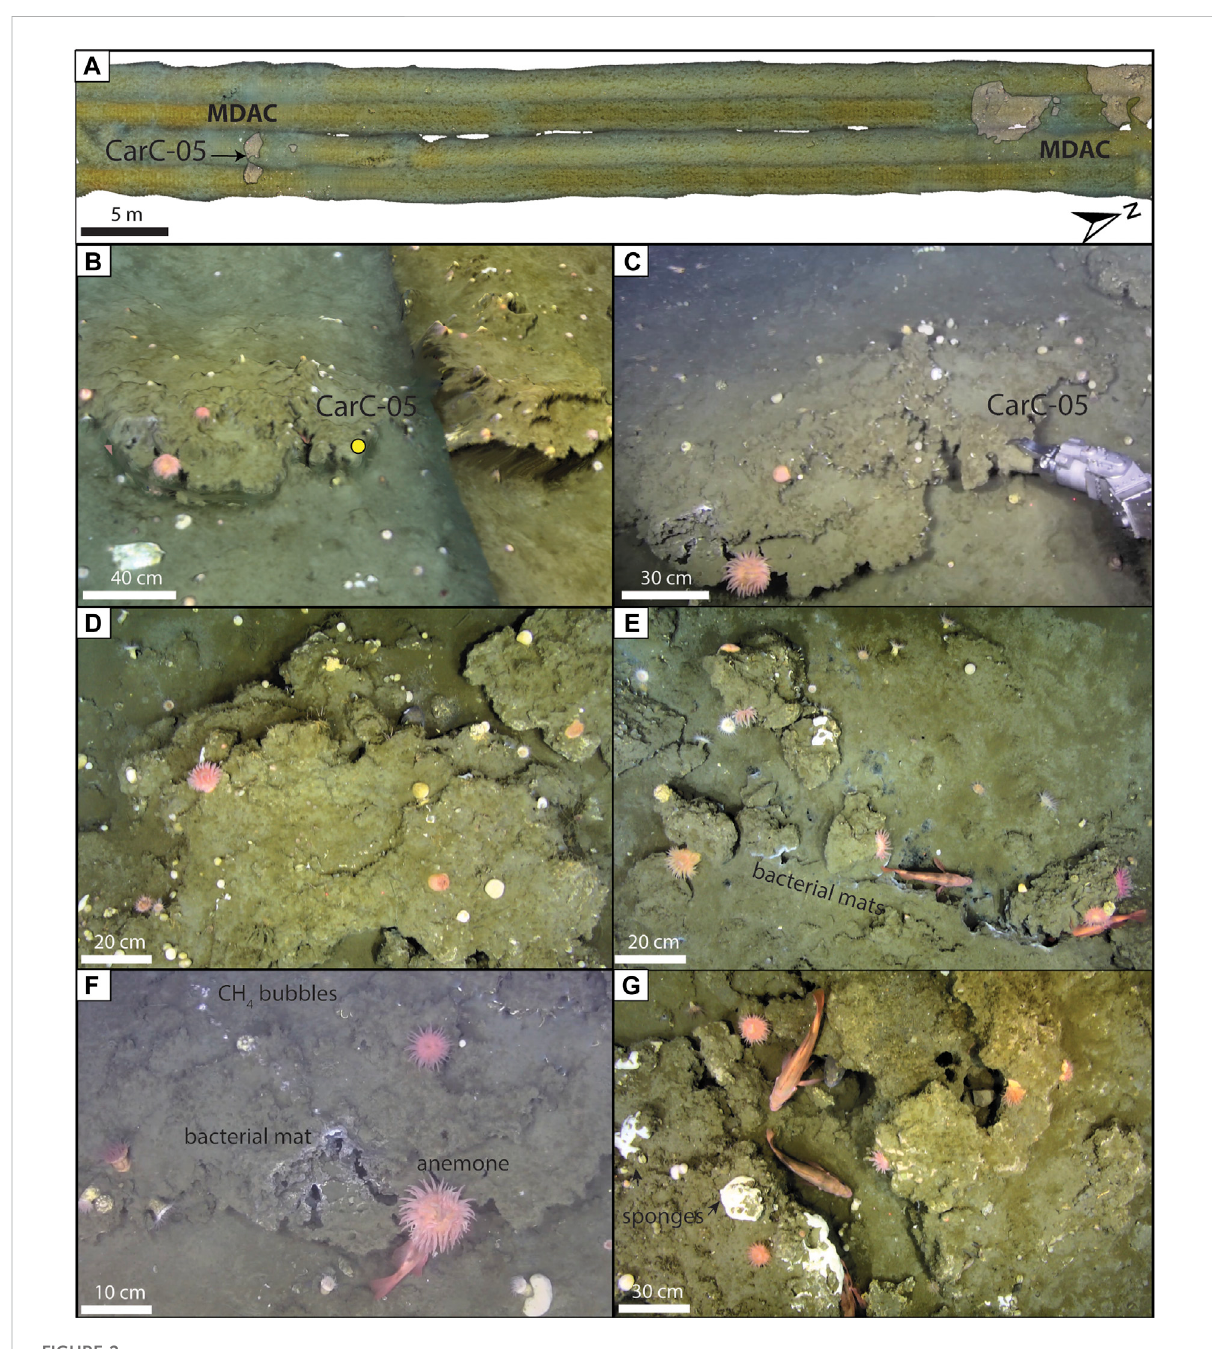
FIGURE 2 Sea fl oorobservationsofthecarbonate outcrops acquiredduring AKMA-CAGE21-1expedition. (A) OrthomosaicoftheROVtransectacrossthe carbonate outcrops. Carbonate bodies are highlighted with pale color. (B) 3D mesh of the carbonate outcrops from which the CarC-05 was collected. (C) Sampling of carbonate sample CarC-05 from a strati fi ed carbonate body using the ROV manipulator arm (front camera). (D) Strati fi ed carbonatedeposits; three layers can berecognized (ortho camera). (E) Bacterialmats colonizedtheouter rimof thecarbonate. Some boulders are found at the base of the carbonate structure (ortho camera). (F) Bacterial mat around a bubbling spot through the carbonate. Methane bubbles are visible in the photograph. Large anemones are distributed on top and on the rim of the carbonate layers (front camera). (G) Anemones and sponges on a carbonate; fi shes hiding in cavities within the carbonate body (ortho